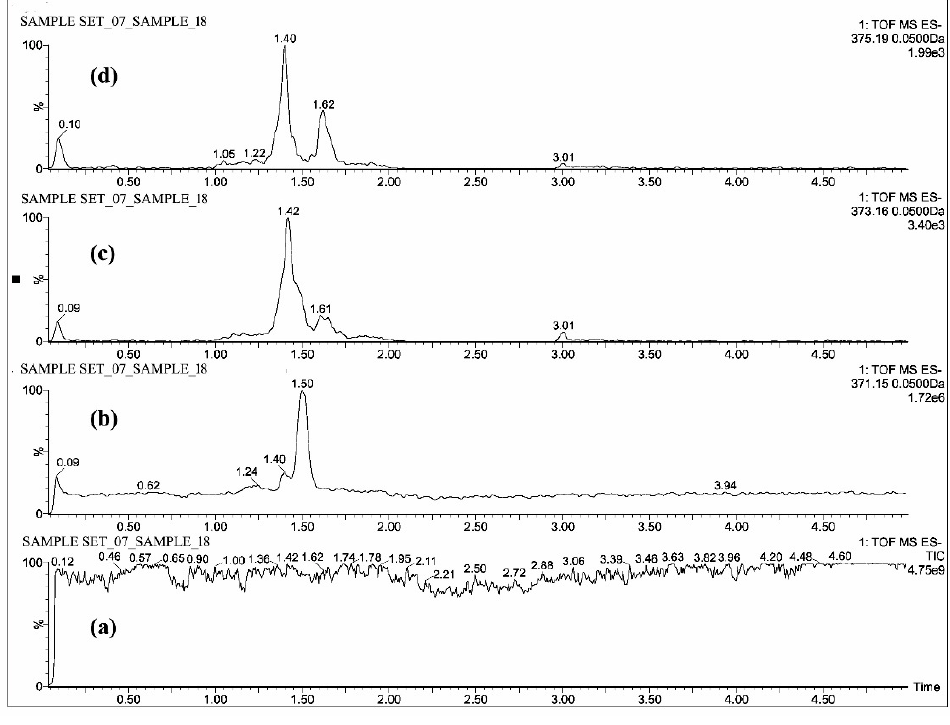
Figure 6. UPLC-QTOF-MS chromatograms of a plasma sample—( a ) total ion chromatogram of hydrogenated curcuminoids, extracted ion chromatograms of ( b ) THC, ( c ) HHC and ( d ) OHC.